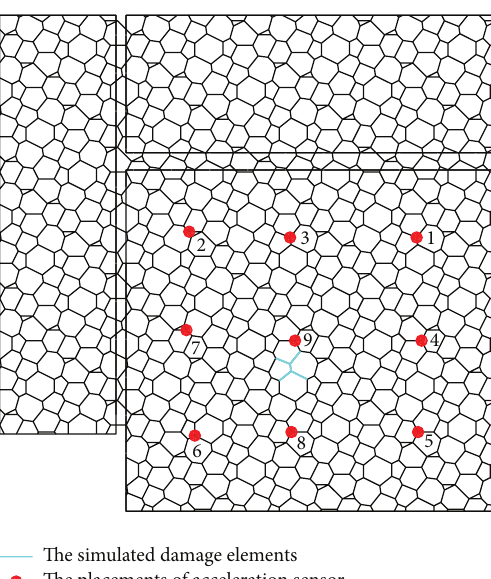
Figure 13: The previous placements of